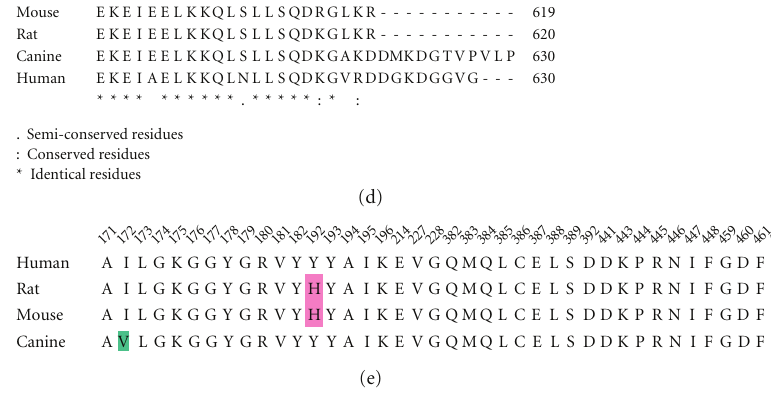
Figure 1: (a) Expression pattern of HRI in human tissues. RT-PCR products from human tissue using HRI specific primers were separated on a 0.8% agarose gel and visualized by UV. Lanes: 1, liver; 2, kidney; 3, lymph node; 4, spleen. (b) RT-PCR products of canine HRI cDNA from spleen. 50 ng of the resulting cDNA PCR products were separated on an agarose gel (0.8%), stained with ethidium bromide and visualized by UV. (c) Nucleotide sequence comparison of the canine HRI with human, rat and mouse HRI. Conserved nucleotides between all four species are denoted with a star. (d) Amino acid sequence alignment of the canine HRI with the mouse, rat, and human HRI. Semi-conserved residues are designated with a period underneath, conserved residues are shown by semicolon underneath, and the identical residues have stars underneath them. The residues important for ATP binding are highlighted in gray. (e) Alignment of the residues involved in ATP binding. Residues important for ATP binding for the human, mouse, rat, and canine HRI are shown. Divergences between the species are highlighted.